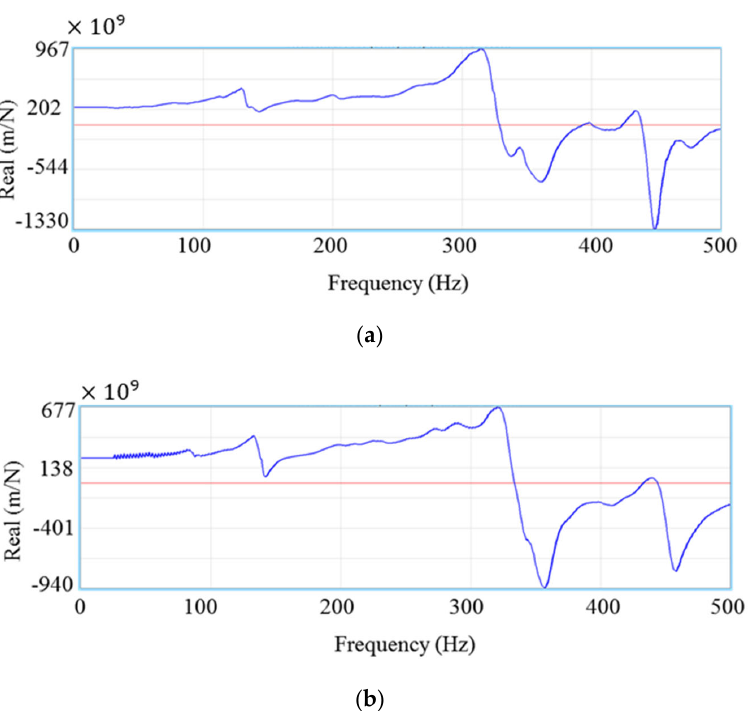
Figure 3. Relationship between feed per tooth and cutting force.